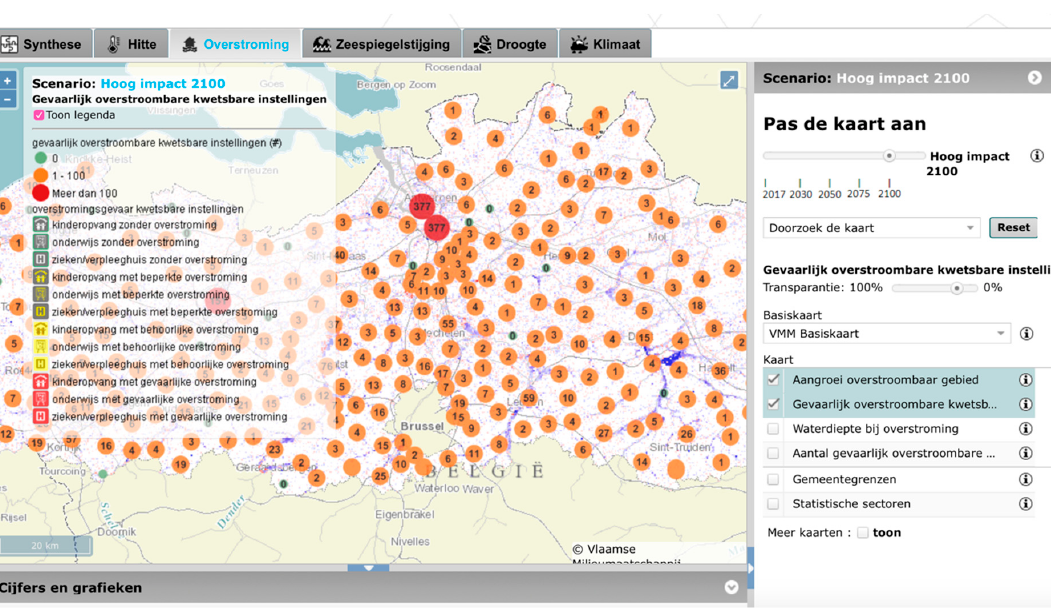
Figure 2. Pluvial flood risk map with climate change scenarios from 2017 to 2100 [84] ( Website of the map: https://klimaat.vmm.be/nl/kaartapplicatie-thema-2 ).